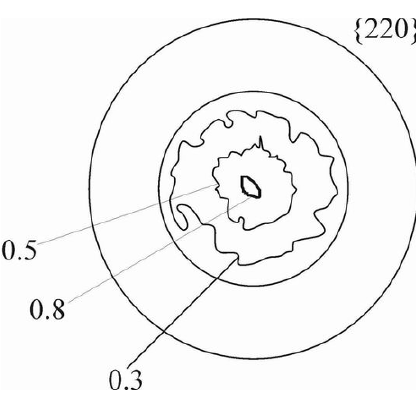
Figure 5. Pole figure {220} of CZT ceramics after compression at T = 25ºC, p = 400 MPa and annealing at T t = 120 min. an